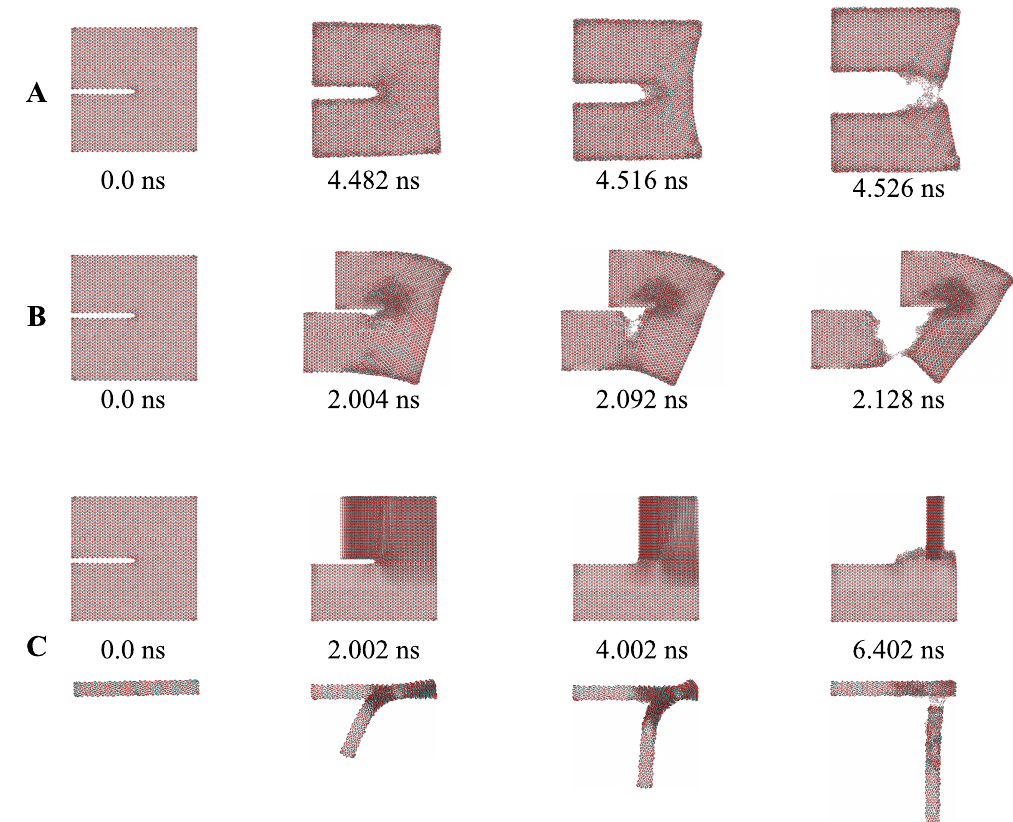
Figure 9. Fracturing of the aragonite tablet with initial flaws. The figures show the cracking under ( A ) Mode I, ( B ) Mode II, and ( C ) Mode III loading